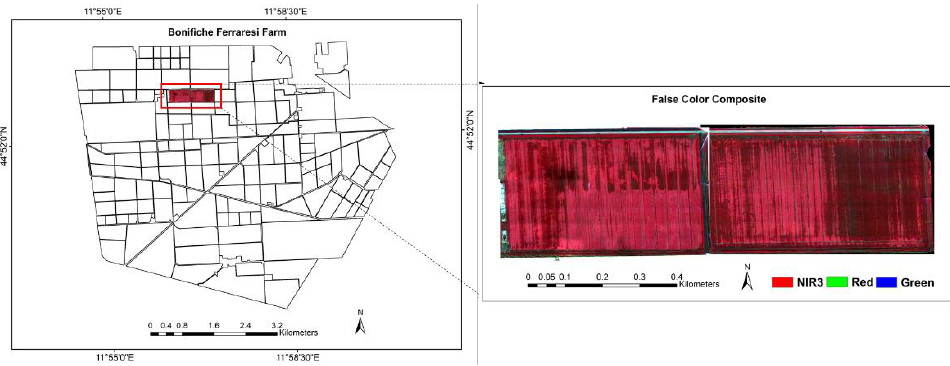
Figure 1. The selected wheat fields (red box) in Bonifiche Ferraresi farm, Jolanda di Savoia, Ferrara, Italy. The location map of the farm is shown on the left and the false colour composite (R: NIR3, G: Red, B: Green) of the UAV data is on the right